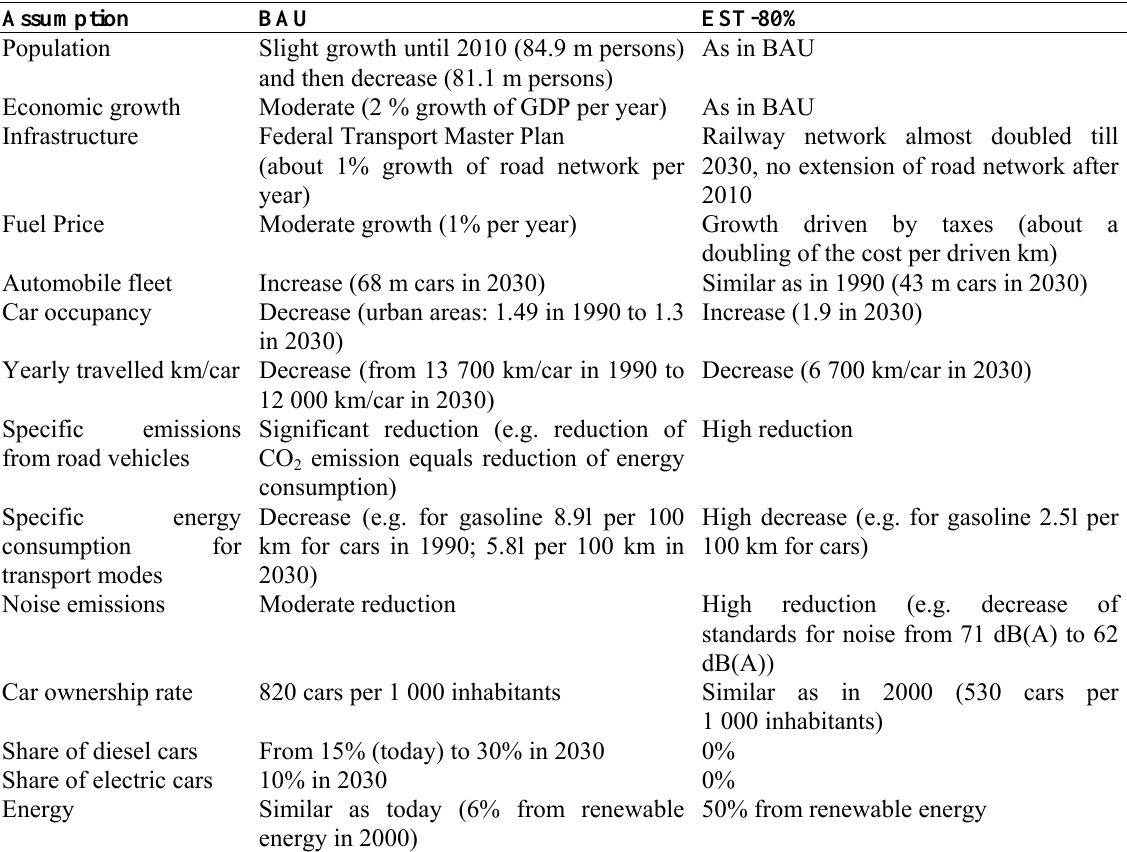
Table 1. Assumptions of BAU and EST-80% (Umweltbundesamt, Wuppertal Institute